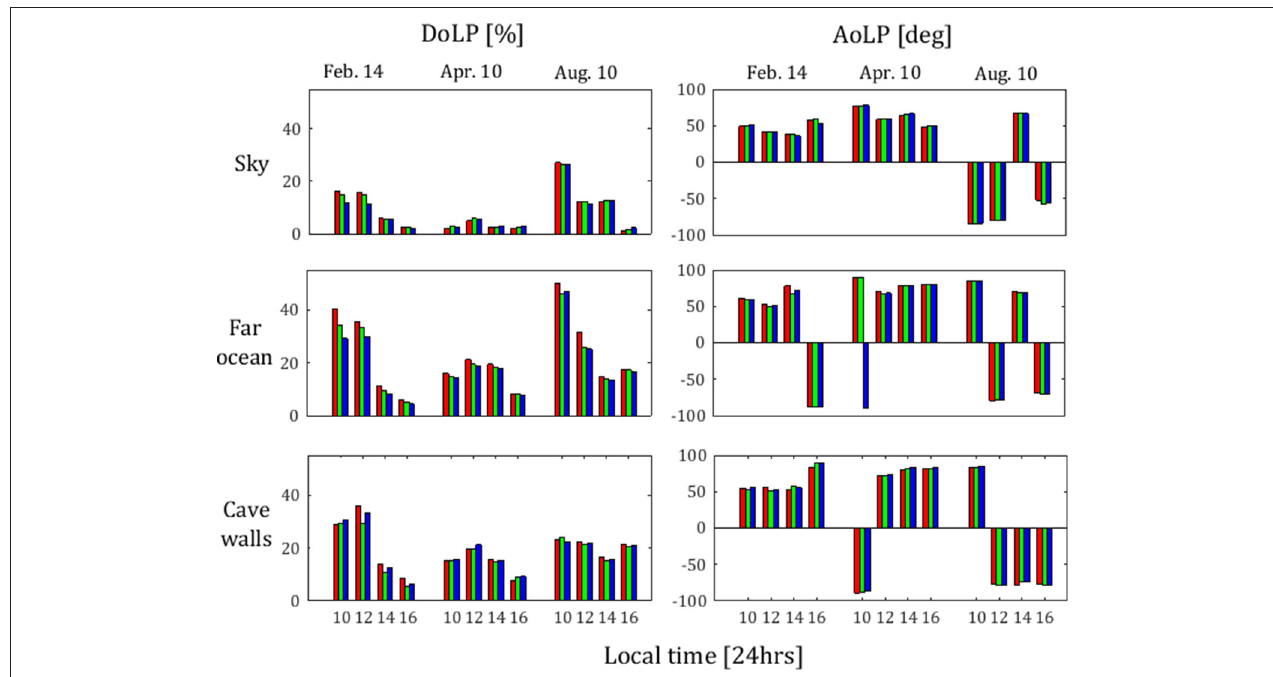
FIGURE 10 | Mean DoLP and mean AoLP for light from sky, far ocean, and cave walls as obtained from polarization photograph method on February 14th, 2016, April 10th, 2016, and August 10th, 2016. The dates and time of day of each measurement are indicated along the horizontal axis. From each measurement values from blue, green, and red wavebands are presented (each in its own color).